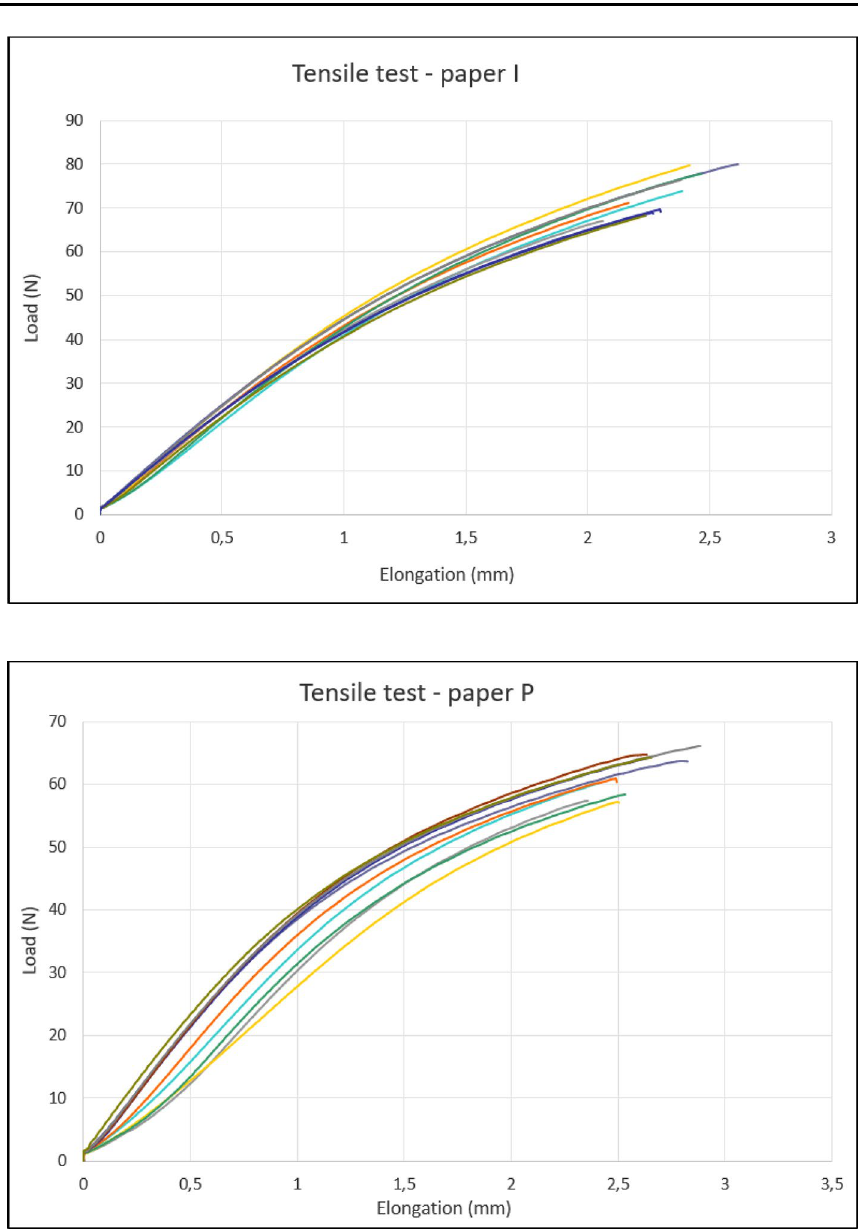
Fig. 40 Force elongation curves of individual specimen